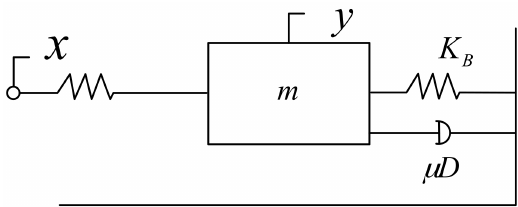
Figure 6. Equivalent model of the PZT displacement platform.